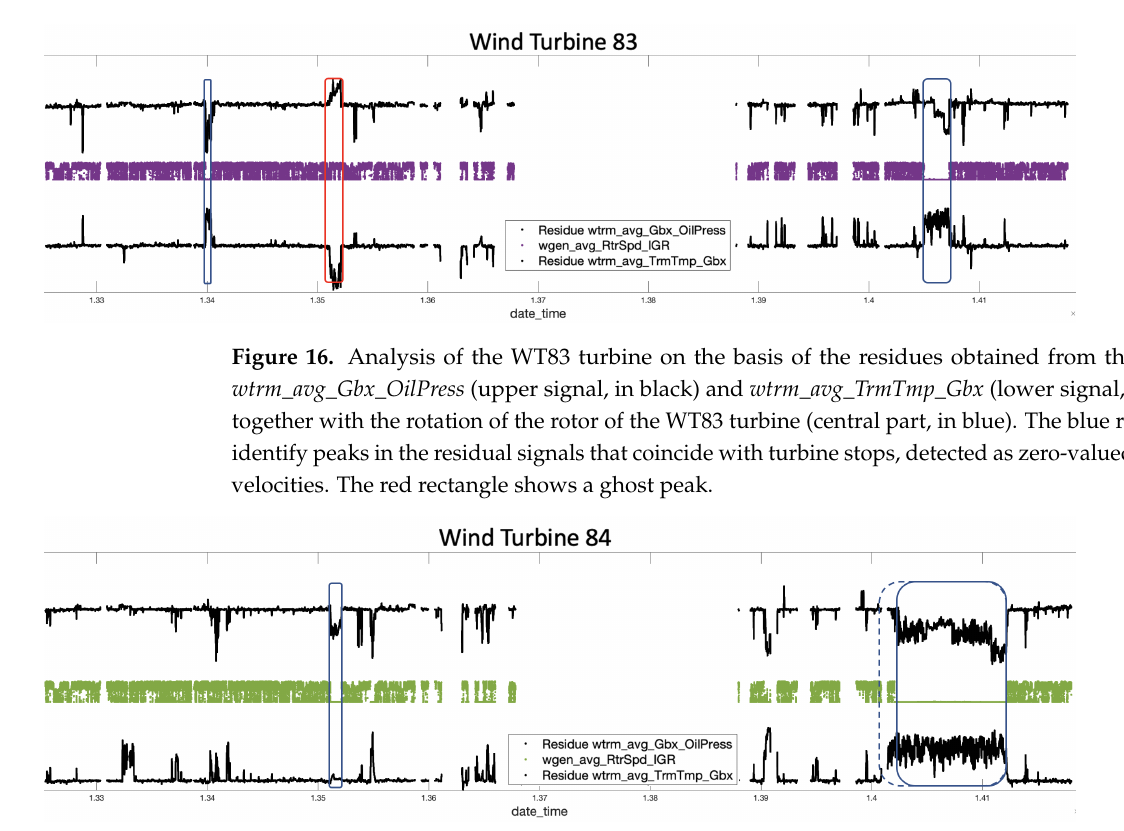
Figure 17. Analysis of the WT84 turbine on the basis of the residues obtained from the signals wtrm_avg_Gbx_OilPress (upper signal, in black) and wtrm_avg_TrmTmp_Gbx (lower signal, in black) together with the rotation of the rotor of the WT84 turbine (central part, in blue). The blue rectangles identify peaks in the residual signals that coincide with turbine stops, detected as zero-valued angular